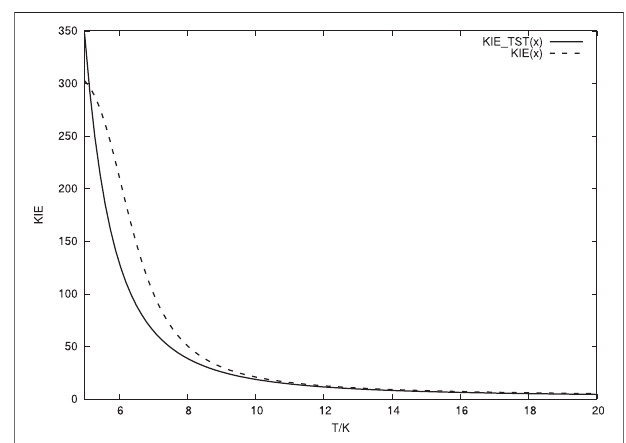
FIGURE 3 | KIE as a function of temperature. “ KIE (x) ” shows the total KIE, while “ KIE-TST ” shows the KIE obtained from the TST contribution to the total hop